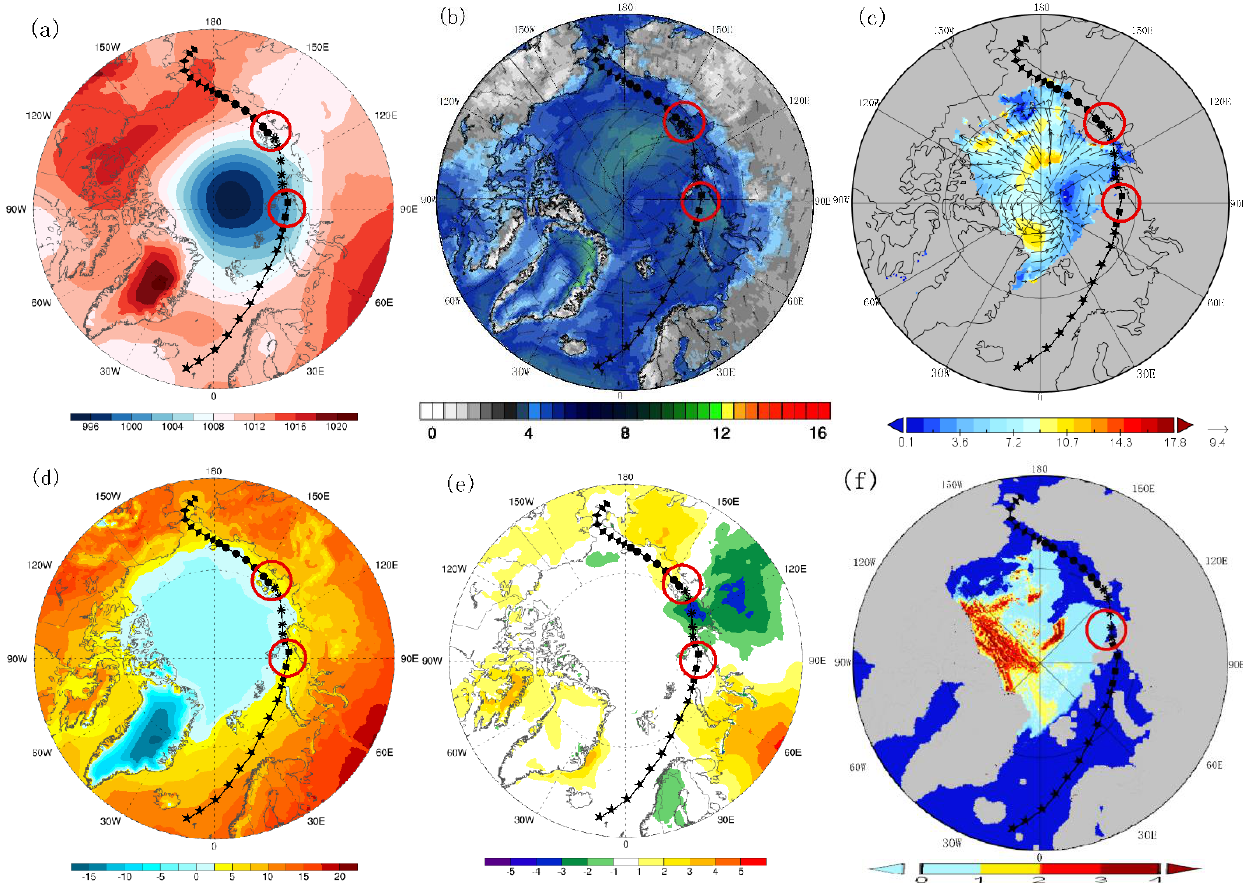
Figure 14. Distribution map of ( a ) sea level pressure (unit: hpa); ( b ) wind field (unit: m −1 ); ( c ) sea ice movement (unit: m −1 ); ( d ) temperature (unit: centigrades); ( e ) temperature anomaly (unit: centigrades) and ( f ) sea ice age (unit: year) in the Arctic summer in August 2016. (The red circles represent the special areas.)